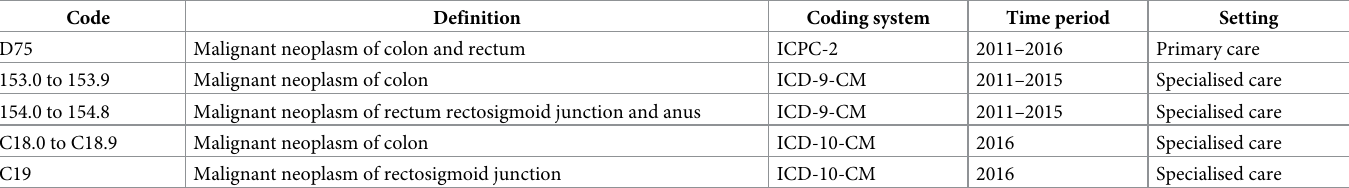
Table 1. Codes used for primary care and specialised care data